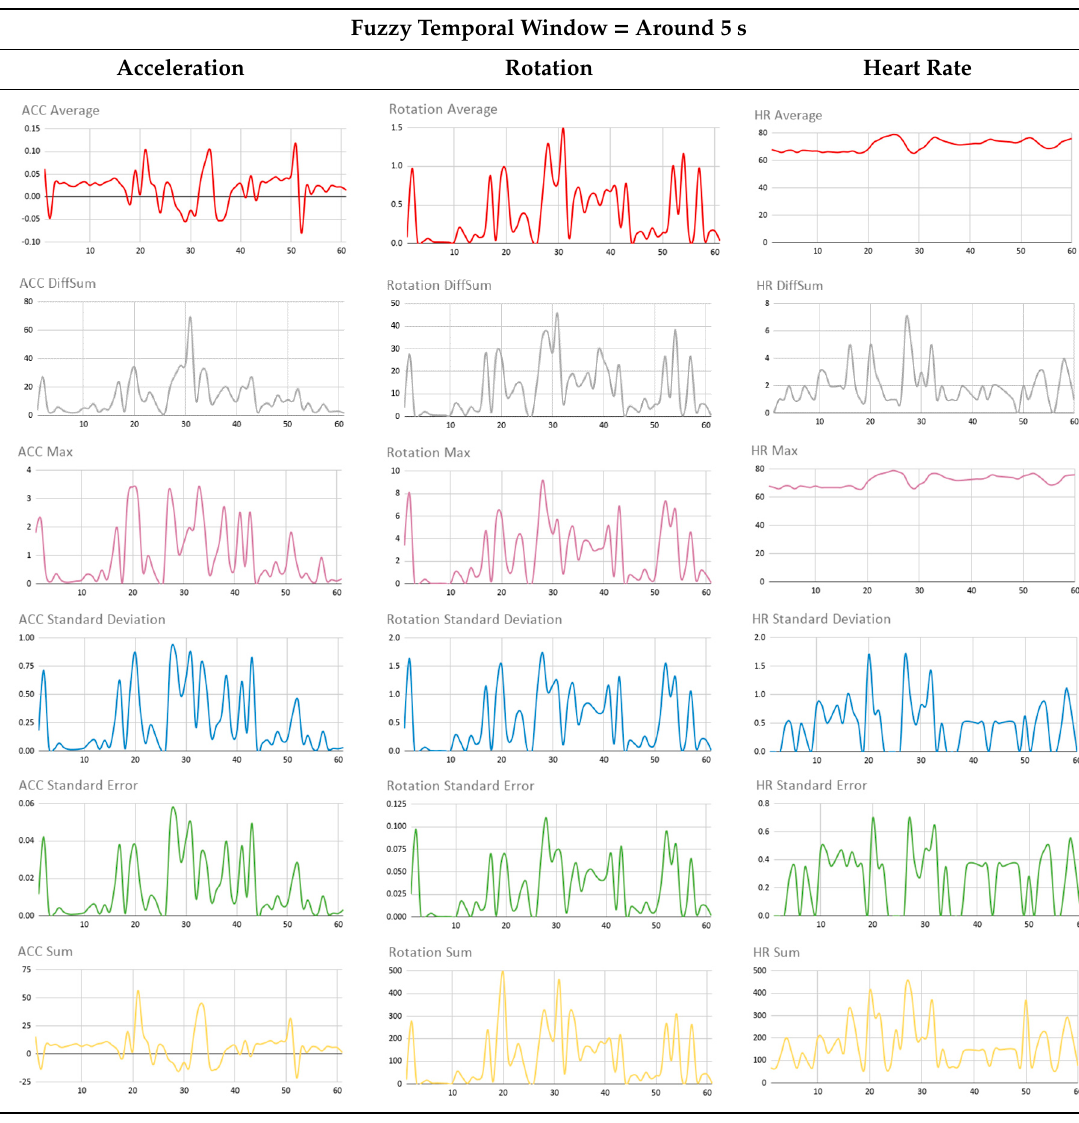
Table 7. Sensor data results with six aggregation operators.